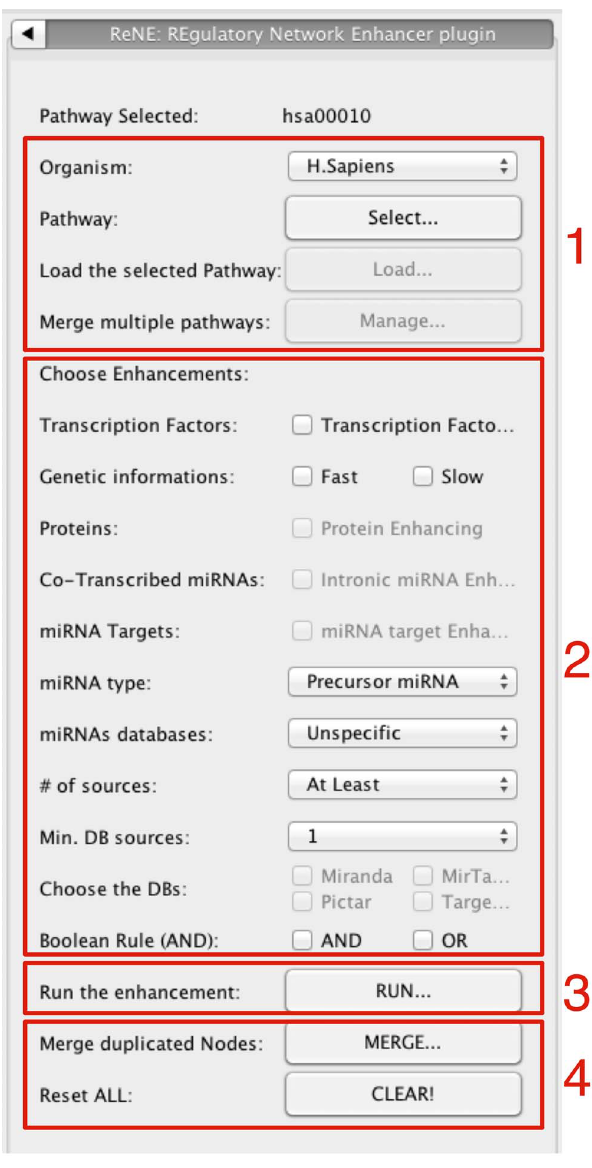
Fig. 4. The image shows the ReNE control panel. Buttons are grouped according to their purpose: (1) Source pathway(s) management; (2) Available enhancements; (3) Run button for executing the selected enhancement; (4) Utility buttons for merging replicated nodes and reset the